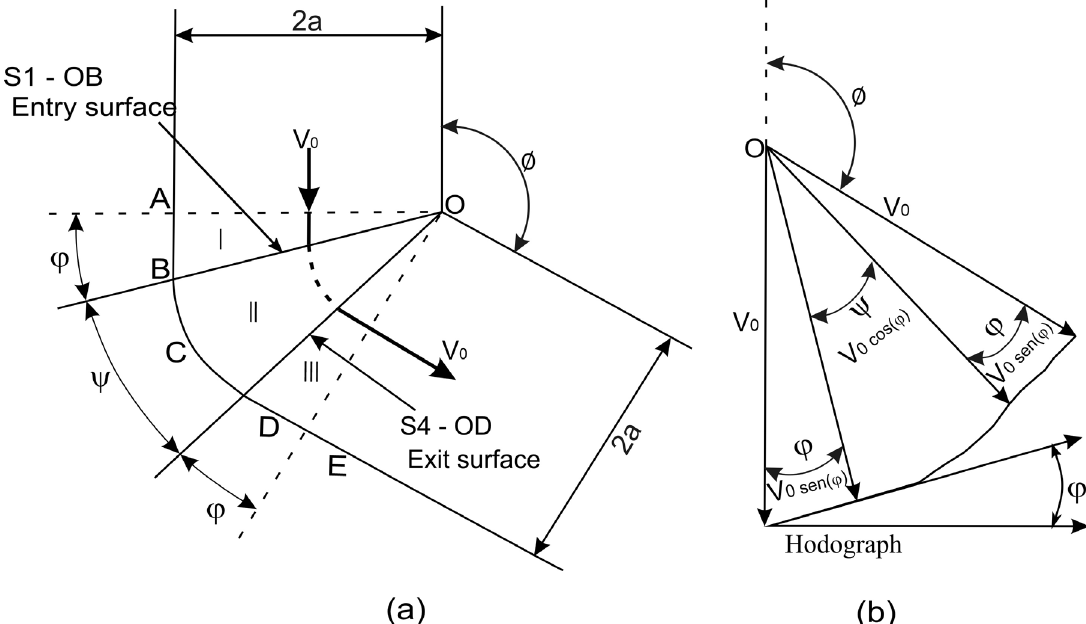
Figure 4. (a) Two-dimensional deformation model used in the ECAP process upper-bound analysis and (b) its